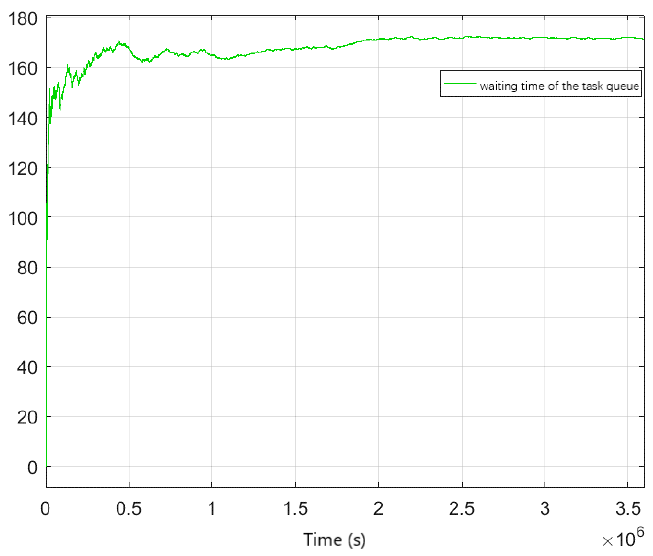
Figure 6. The waiting time curve of the task queue.